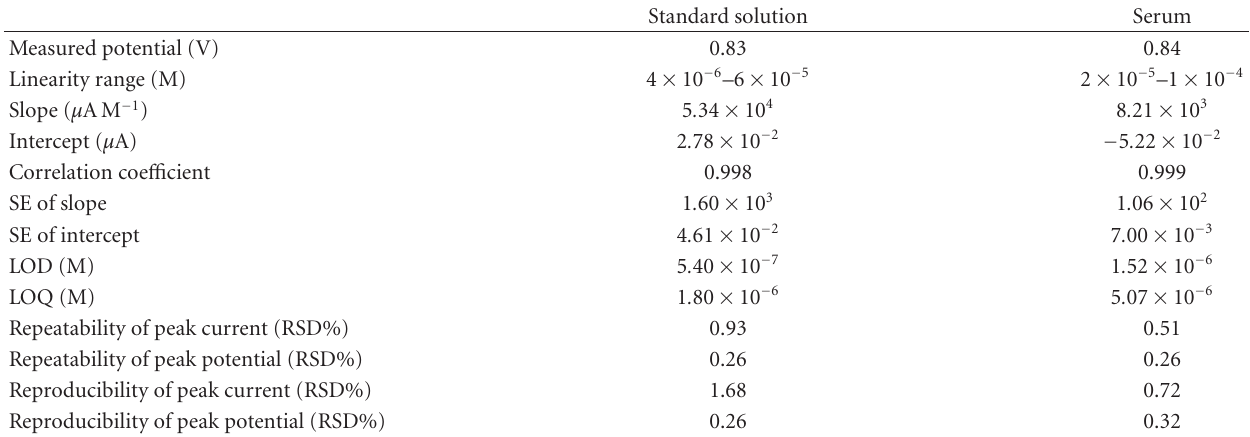
Figure 3: E ff ect of pH on fulvestrant anodic peak potential (a) and peak current (b); fulvestrant concentration: 8 × 10 − 5 M. ( (cid:2) ) 0.1 M sulphuric acid; ( (cid:2) ) 0.2 M phosphate; ( (cid:3) ) 0.2M acetate; ( ♦ ) 0.04 M BR bu ff ers. Table 1: Regression data of the calibration curve and quantitative determination of fulvestrant by DPV in standard solution and human serum.